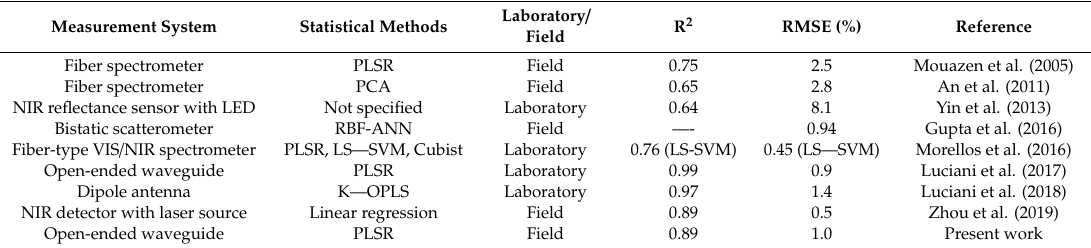
Table 1. Comparison of papers regarding soil moisture